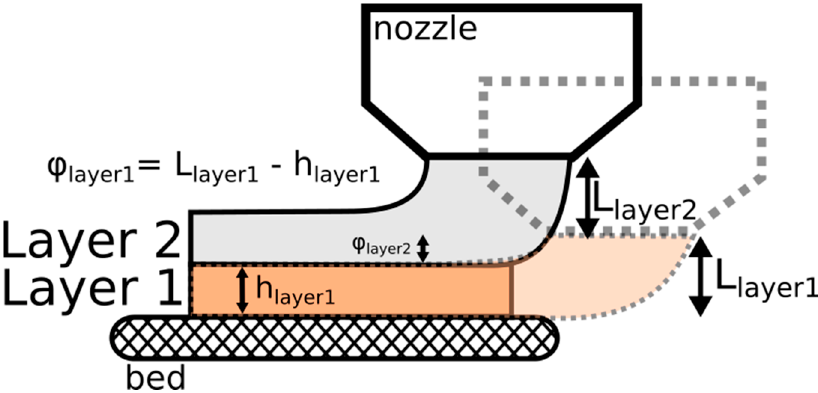
Figure 1. Schematic labelling printing parameters for dual-layered or multi-material printing.